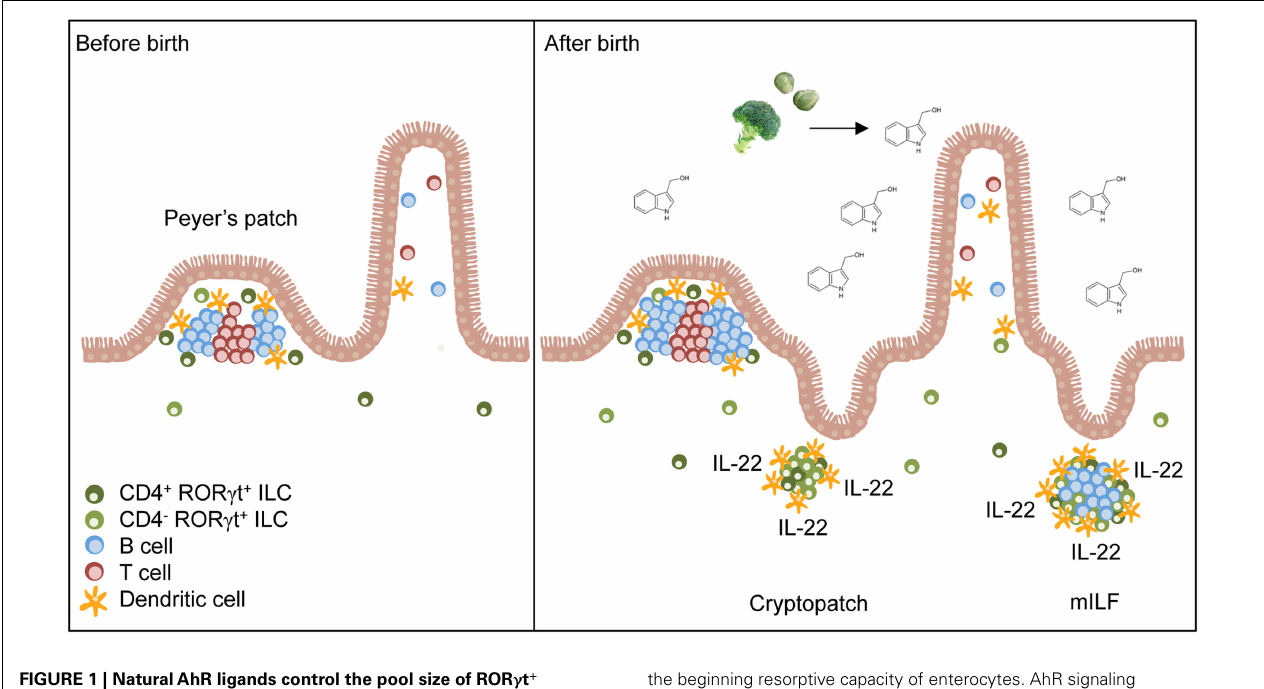
FIGURE 1 | NaturalAhR ligands control the pool size of ROR γ t + ILC. Secondary lymphoid organs (e.g., Peyer’s patches) of the small intestine form before birth and their development is independent of AhR signals. After birth, the amount of dietary AhR ligands such as glucosinolate-derived indole-3-carbinol increases in the intestine due to